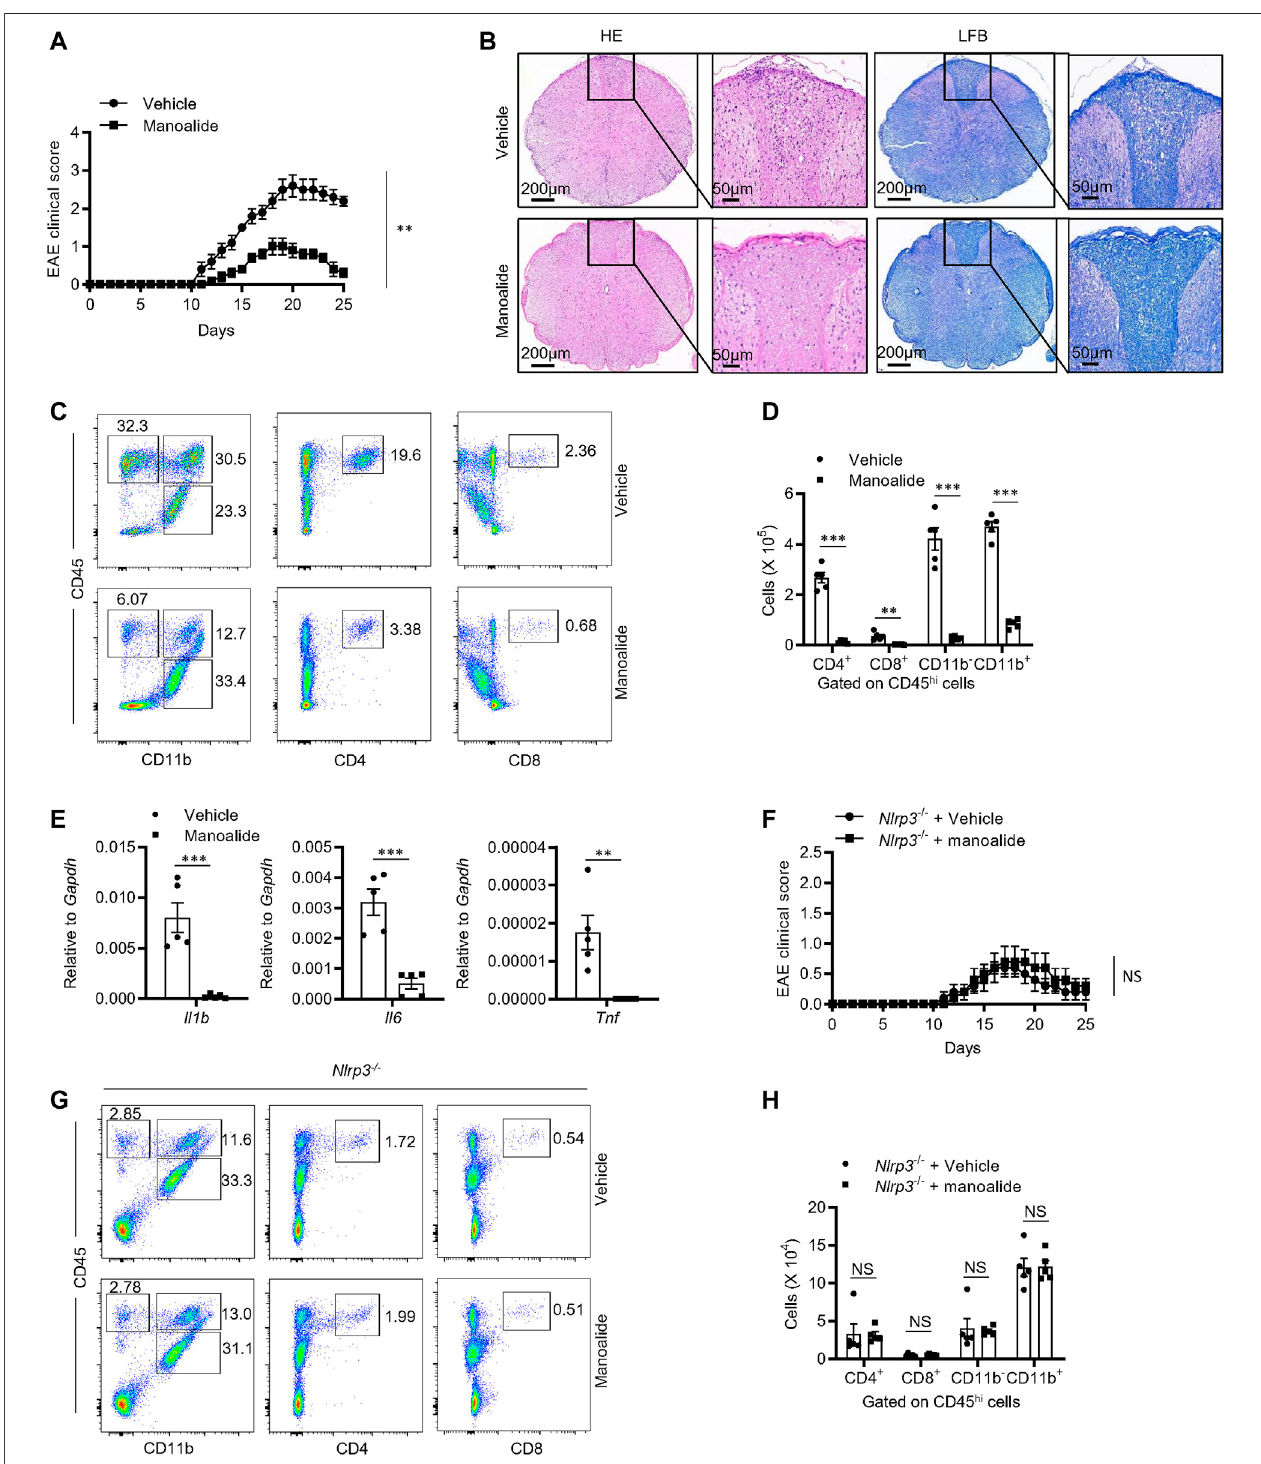
FIGURE 7 | Manoalide attenuates the severity of EAE in an NLRP3-dependent manner. (A-E) WT mice were injected intraperitoneally with manoalide (5 mg/kg) or PBS every 3 days after induction of EAE. (A) Clinical scores was assessed after EAE induction. (B) Sections of paraf fi n-embedded spinal cord tissues from mice in the presence or absence ofmanoalide after EAE induction were stained withH&E or Luxol fast blue (LFB). (C) FACS analysisof liveCD4 + , CD8 + , CD11b + and CD11b − cells gate on CD45 hi cells in the CNS on the 15 days after induction of EAE. (D) The numbers of live CD4 + , CD8 + , CD11b + and CD11b − cells gate on CD45 hi cells in the CNS on the 15 days after induction of EAE. (E) The mRNA levels of IL-1 β , IL-6 and TNF- α in CNS were evaluated by real-time PCR. (F-H) Nlrp3 − / − mice were injected